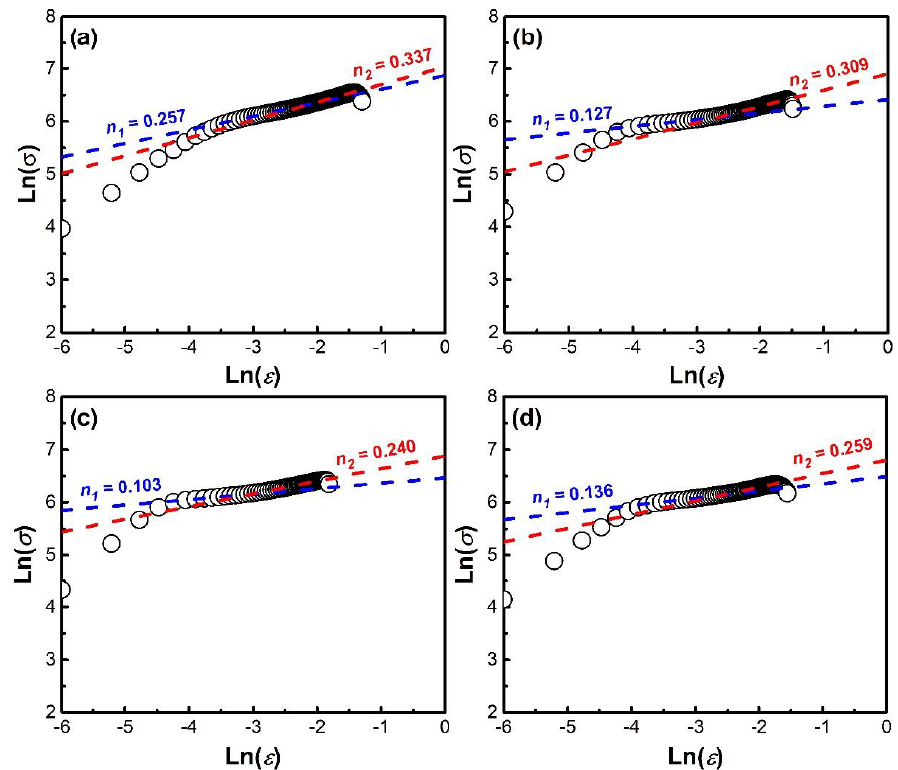
Figure 6. ln( σ )-ln( ε ) plots of the base ( a ), W1 ( b ), W2 ( c ) and W3 ( d ).